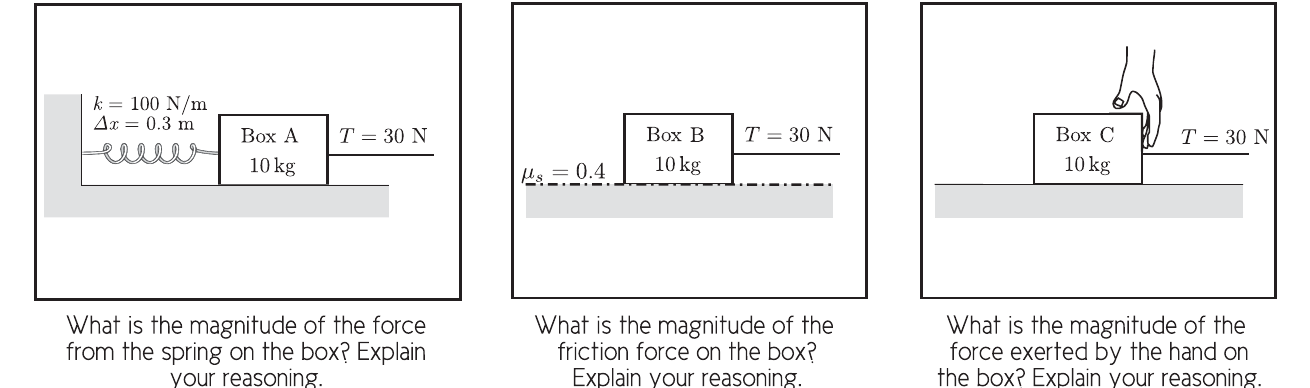
FIG. 3. The figures for the three tasks given in the reflective condition. In each case, the student was asked to find the magnitude of the force of friction, the spring force, or the force applied by the hand. After all three questions were answered, a follow-up question asked the student to consider why certain information was not needed to determine these forces.